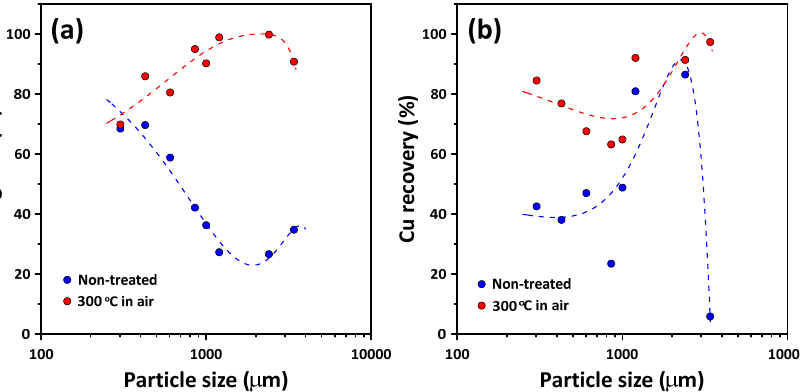
Figure 9. Cu ( a ) grade and ( b ) recovery of the crushed PCB particles (PCB-WT) and ( b ) the crushed PCB particles by electrostatic separation treated at 300 °C in air (PCB-A300).